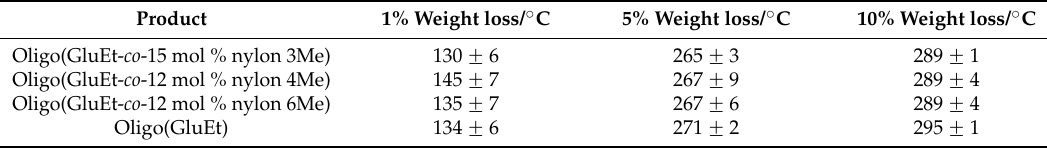
Figure 7. Thermal profiles of (I) oligo(GluEt); (II) oligo(GluEt- co -15 mol % nylon 3Me); (III) oligo(GluEt- co -12 mol % nylon 6Me); and (IV) oligo(GluEt- co -12 mol % nylon 4Me). ( a ) TGA and DSC from 30 to 400 °C at 20 °C/min; ( b ) Magnified TGA plot in the temperature range from 250 to 350 °C in ( a ). Table 2. Degradation temperature at 1, 5, and 10 wt % weight loss of oligo(GluEt- co -15 mol % nylon 3Me), oligo(GluEt- co -12 mol % nylon 4Me), and oligo(GluEt- co -12 mol % nylon 6Me) ( n =